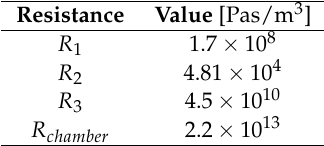
Table A3. Microfluidic